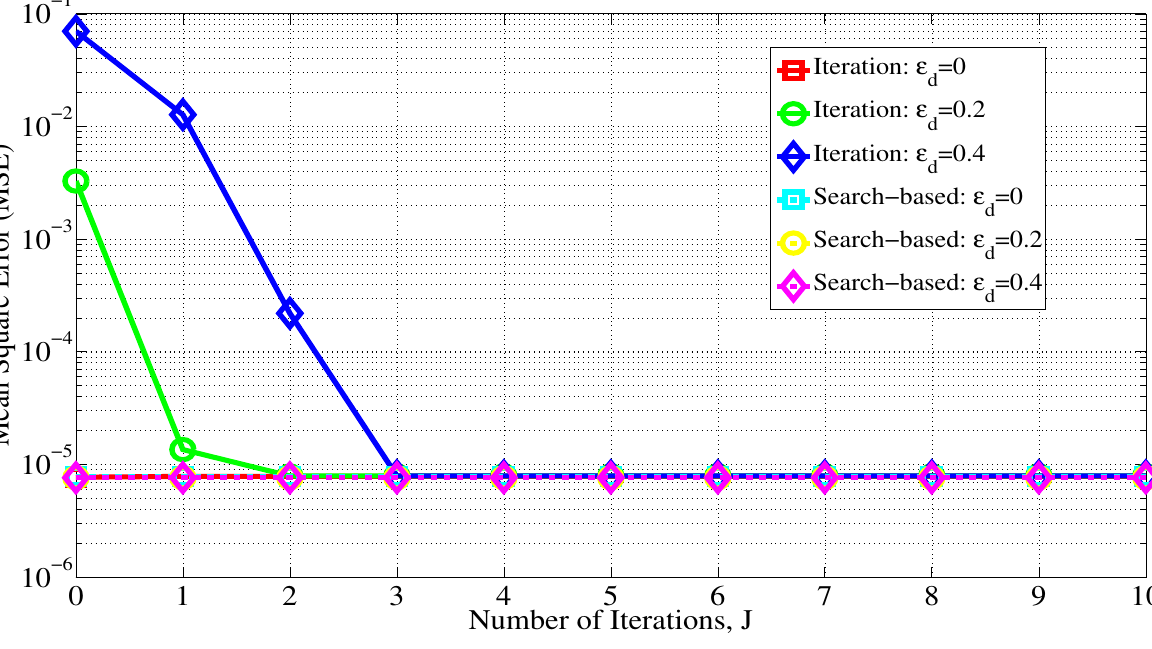
Figure 2. Convergence behavior of the proposed iterative CFO estimation for different CFOs. N = 256, K = 64, SNR = 30 dB and τ =